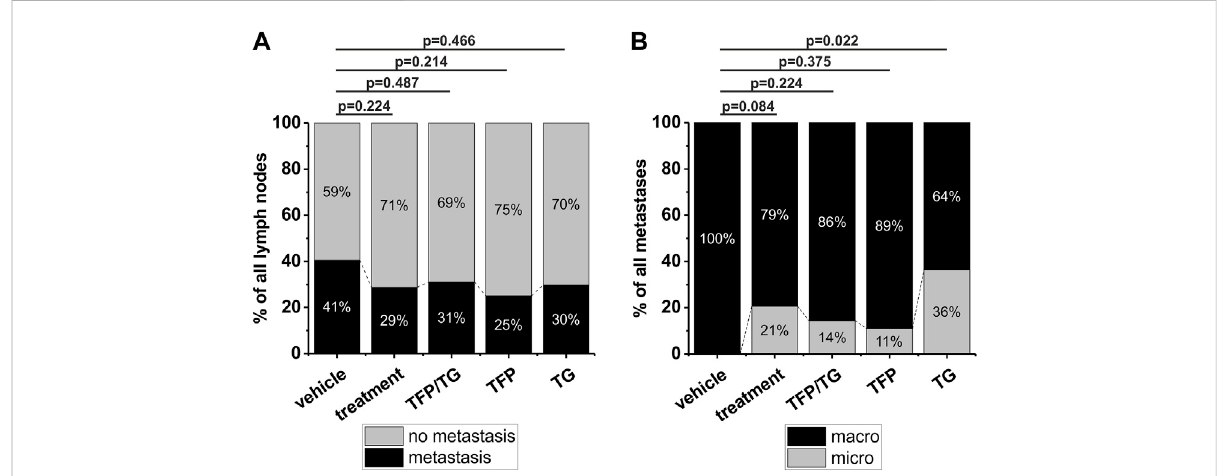
FIGURE 3 Impact of different drug treatments on metastasis growth and metastasis size in 40 NOD-SCID mice. Groups compared to each other are vehicle ( n = 9), treatment ( n = 31) that includes all treatments in general, combinatory treatment TFP/TG (15 mg/kg TFP, 0.4 mg/kg TG) (n = 11), 15 mg/kgTFP( n =10)and0.4 mg/kgTG(n=10).After5 – 7 weeksofdrugdeliverythreetimesperweekanimalsweresacri fi ced,tonguesandcervical lymph nodes were dissected and further processed for histological analysis including HE staining. (A) Comparison of the number of detectable metastases of all dissected lymph nodes in vehicle animals versus the above-mentioned groups. Animals which received TFP and TG in a combination therapy, got drugs with 1 h in-between drug delivery. (B) Comparison of the detectable metastasis size in vehicle animals versus the aforementioned groups. Signi fi cance was tested using a Fisher´s exact